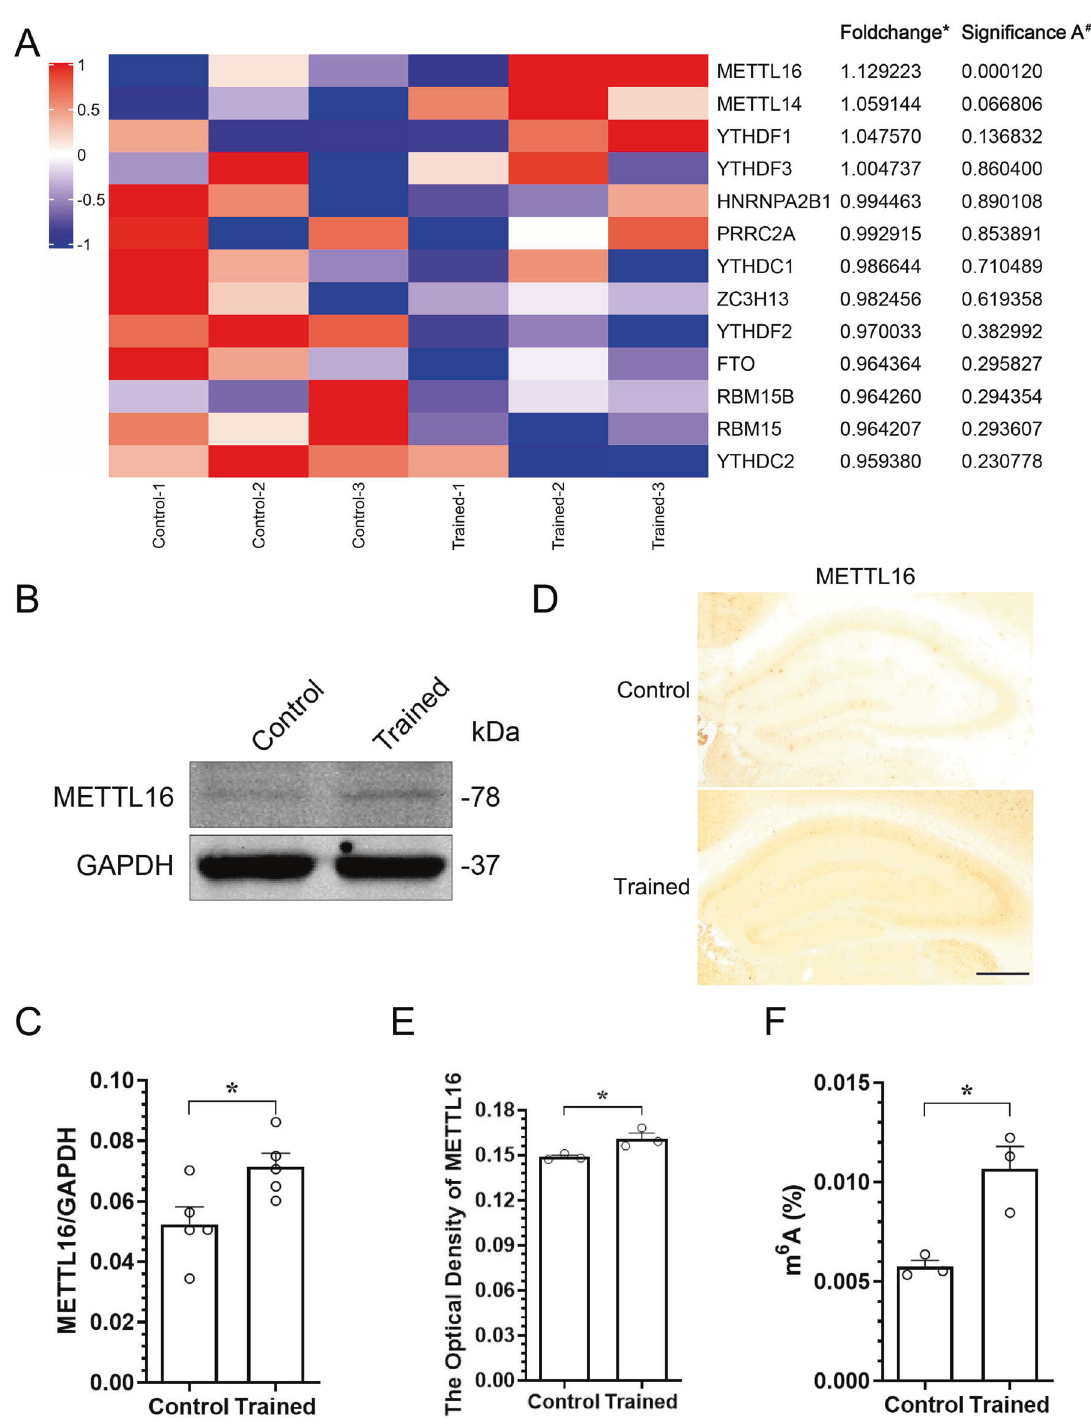
Fig. 1 METTL16 is upregulated in the hippocampi of MWM-trained mice. A Expression levels of RNA m 6 A methylation modi fi cation proteins in the hippocampi of the MWM training mice from our proteomic data (PXD032022; http://proteomecentral.proteomexchange.org). *The fold change of trained group ( n = 3) vs control group ( n = 3). # MaxQuant was used to assess the statistical signi fi cance [28]. B , C Representative western blotting ( B ) and quanti fi cation of METTL16 ( C ) in the hippocampi of MWM-trained ( n = 5) and untrained mice ( n = 5). D , E Representative IHC images ( D ) and quanti fi cation of METTL16 ( E ) in the hippocampi of MWM-trained ( n = 3) and untrained mice ( n = 3); Scale bars = 500 μ m. F Overall levels of m 6 A in the hippocampi of MWM-trained ( n = 3) and untrained mice ( n = 3) tested by m 6 A colorimetry. Data shown as the mean ± standard error of the mean (SEM). P- values were determined by two-tailed t -test. * P < 0.05.